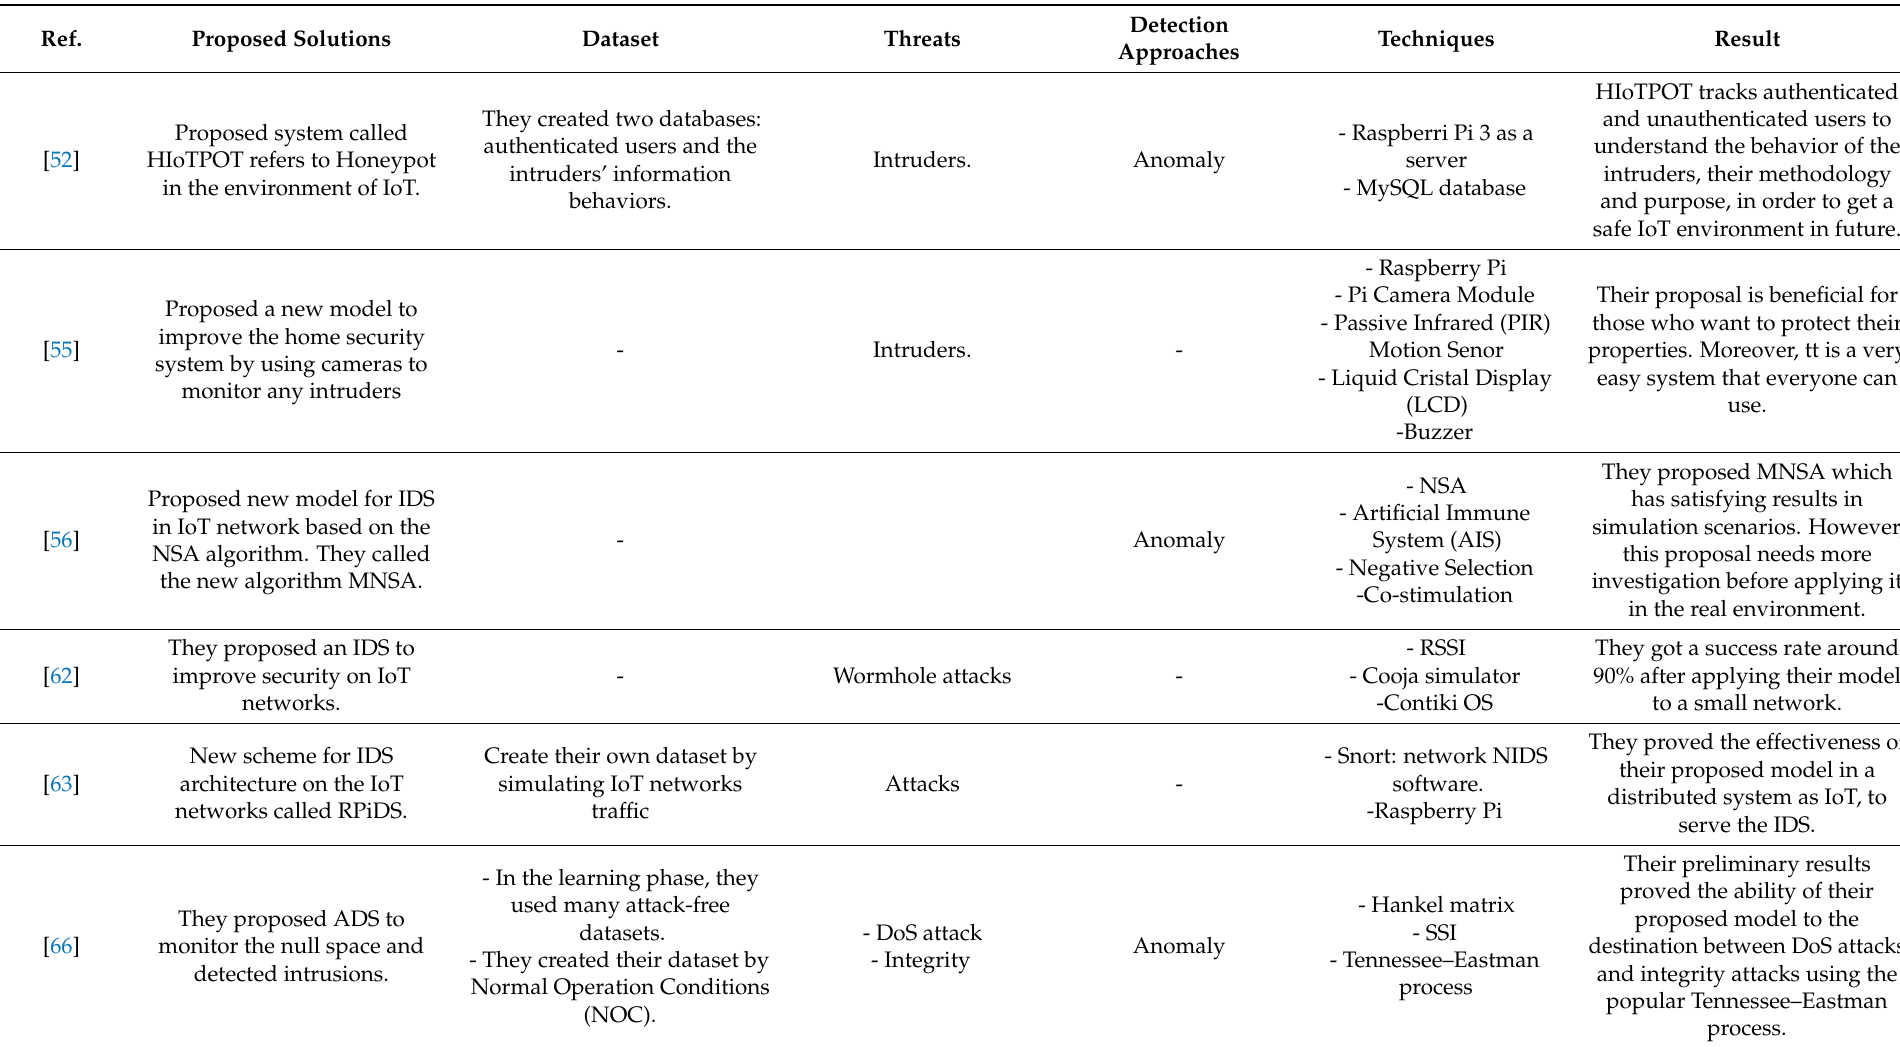
Table 4. IDS- based security solution in